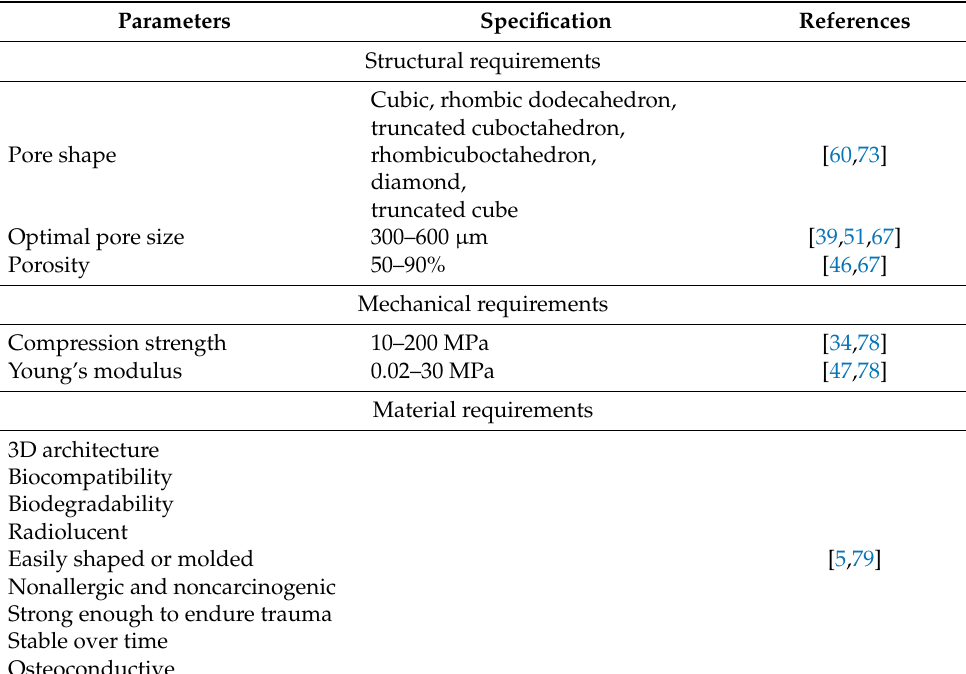
Table 2. Structural, mechanical, and material requirements of a bone